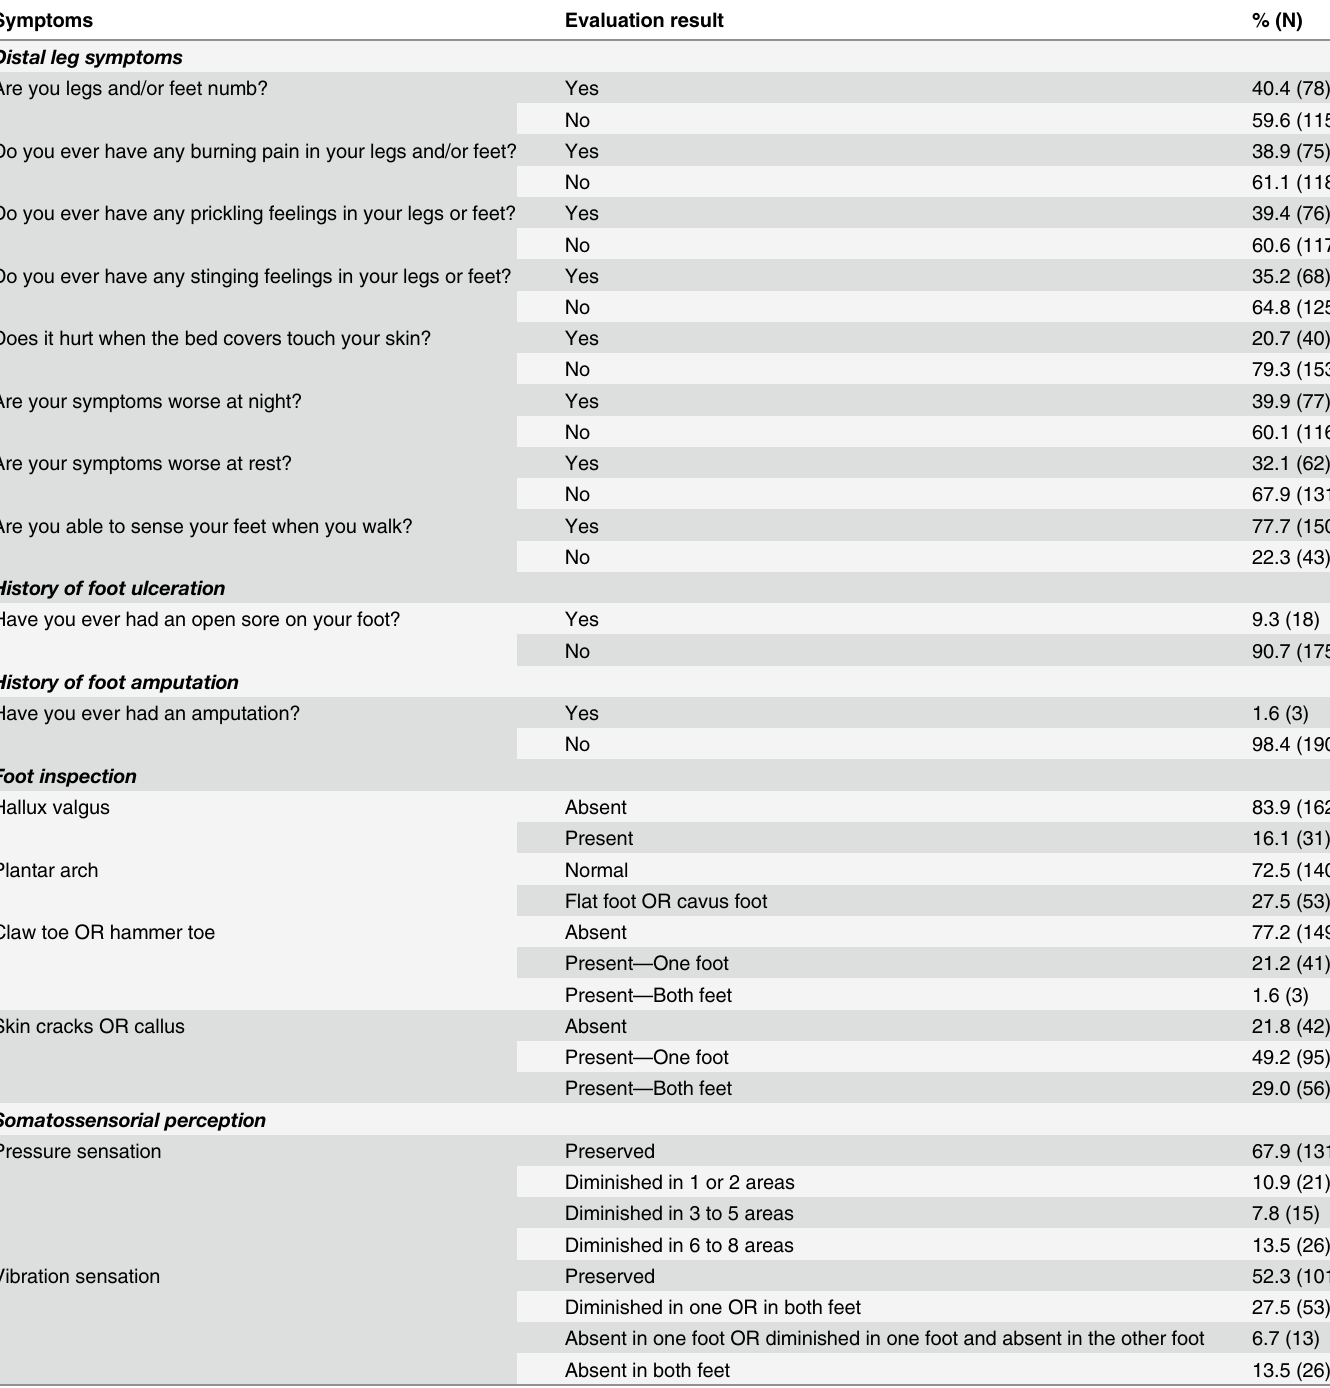
Table 3. Frequency distribution of patients that were allocated in each of the DPN related variables modalities. Symptoms Evaluation